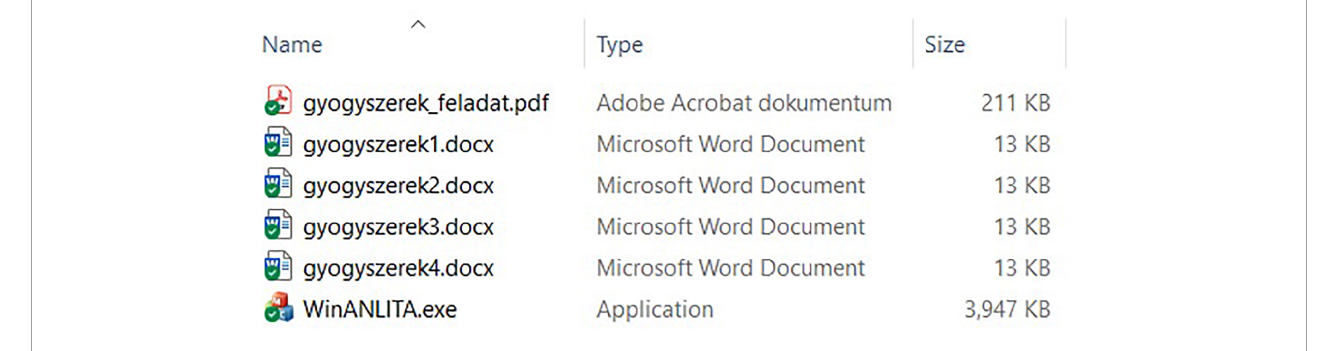
FIGURE3 Visible files of the ANLITA software package folder for testing.